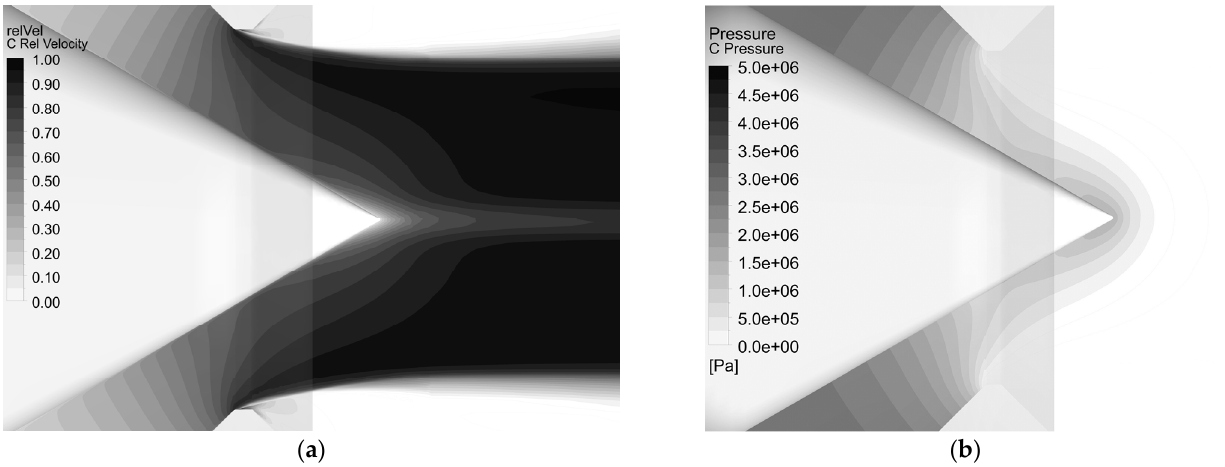
Figure 9. Velocity and pressure distribution at the nozzle exit: ( a ) relative velocity; ( b ) pressure. The hydraulic losses H v in the distributor are determined as a hydraulic head loss from the inlet to the outlet of the corresponding nozzles. H v is given in Equation (3) whereby p and p represent mass flow averaged total pressure values at the inlet and a plane at the nozzle exit. This plane was placed 30 mm upstream from the corresponding changing flow physics of the flow on the result.